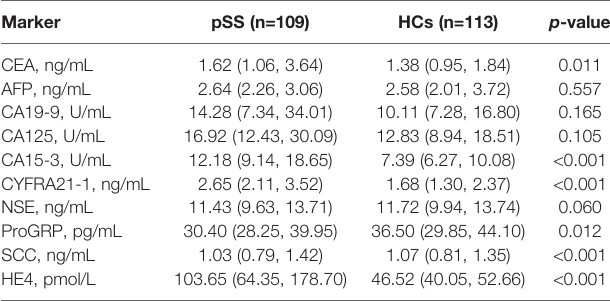
TABLE 1 | Demographic and clinical characteristics between patients with primary Sjögren ’ s syndrome (pSS) and healthy controls (HCs). Variables